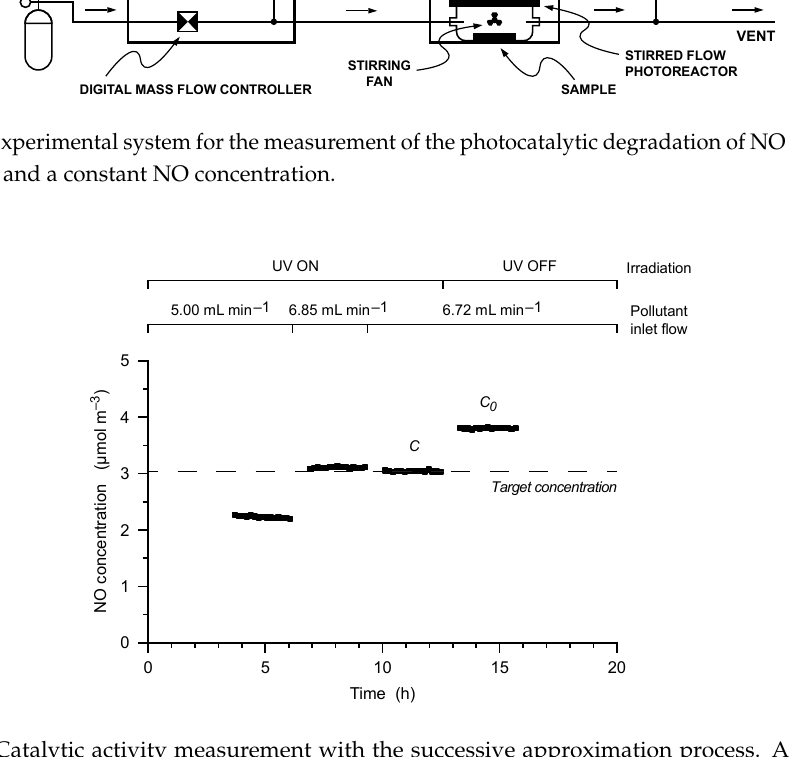
Table 2. Composition (wt %), curing conditions, apparent density, and open porosity of the samples used in this study. Photocatalyst (3% w / w ) was added to all formulations immediately after preparation.